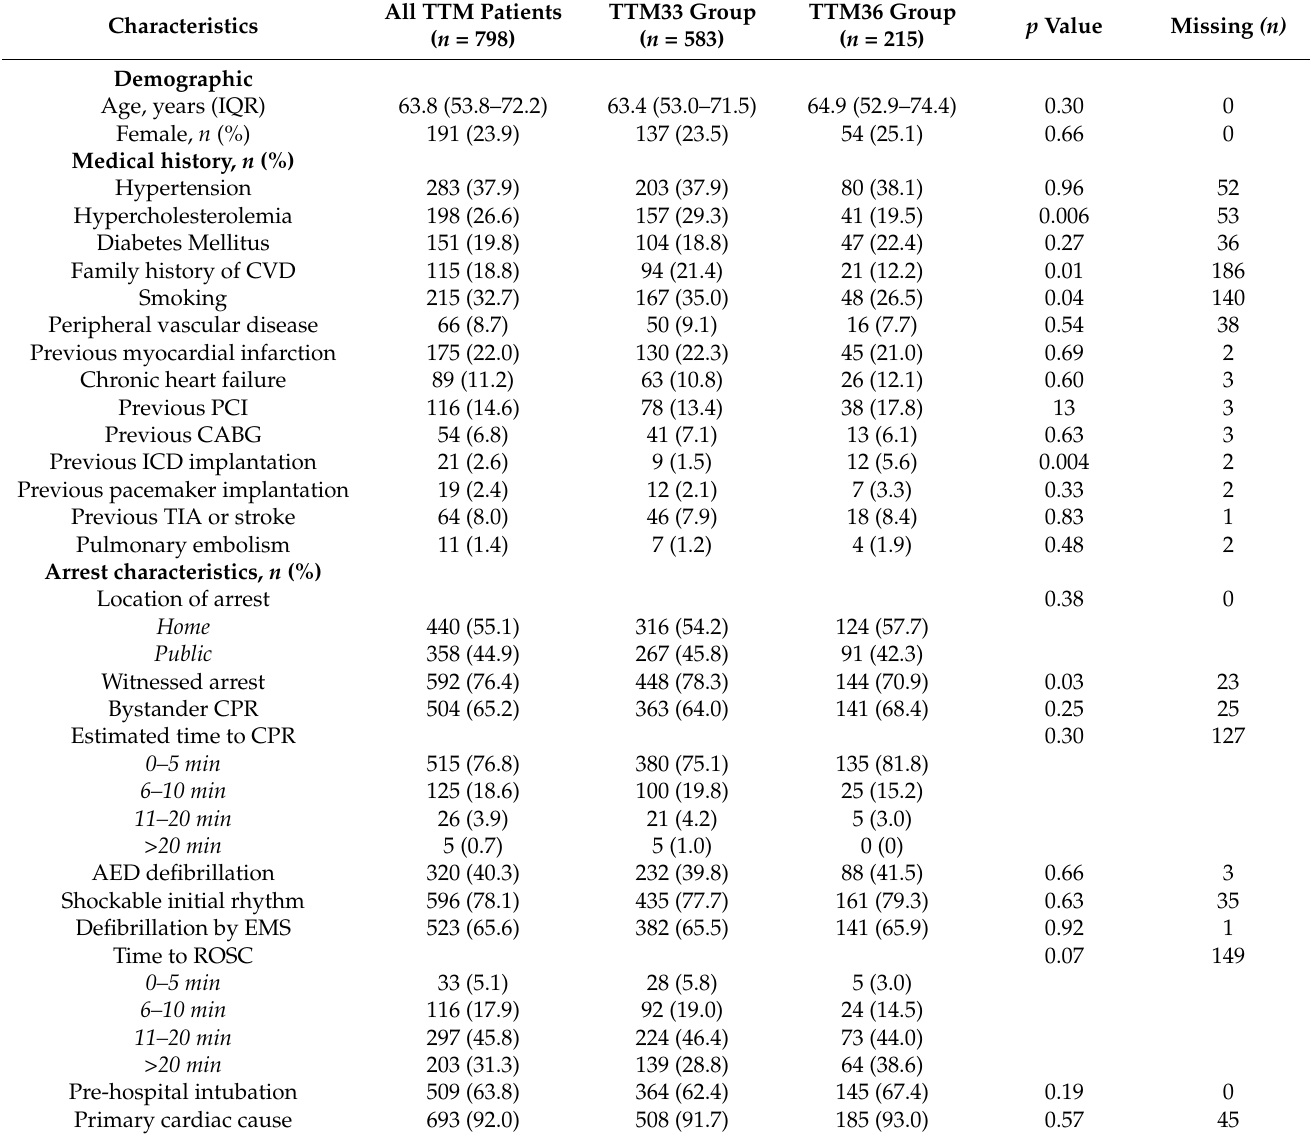
Table 1. Patient and arrest characteristics in OHCA patients admitted to the